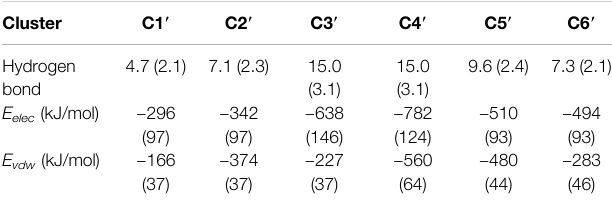
TABLE 1 | Hydrogen bonds and interaction potential energies between A β 42 and HSAcalculatedforeachcluster.Interactionenergiesaredecomposedintothe electrostatic ( E elec ) and van der Waals ( E vdw ) terms. Standard deviations are given in parentheses.